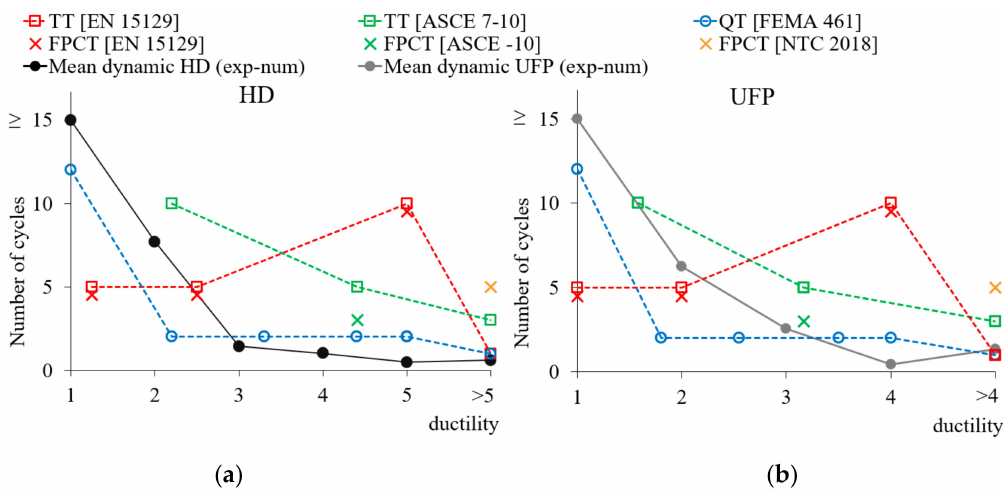
Figure 15. Number of cycles estimated from experimental dynamic tests compared with the codes requirements for ( a ) HDs of the steel braced frame and ( b ) UFPs of the timber braced